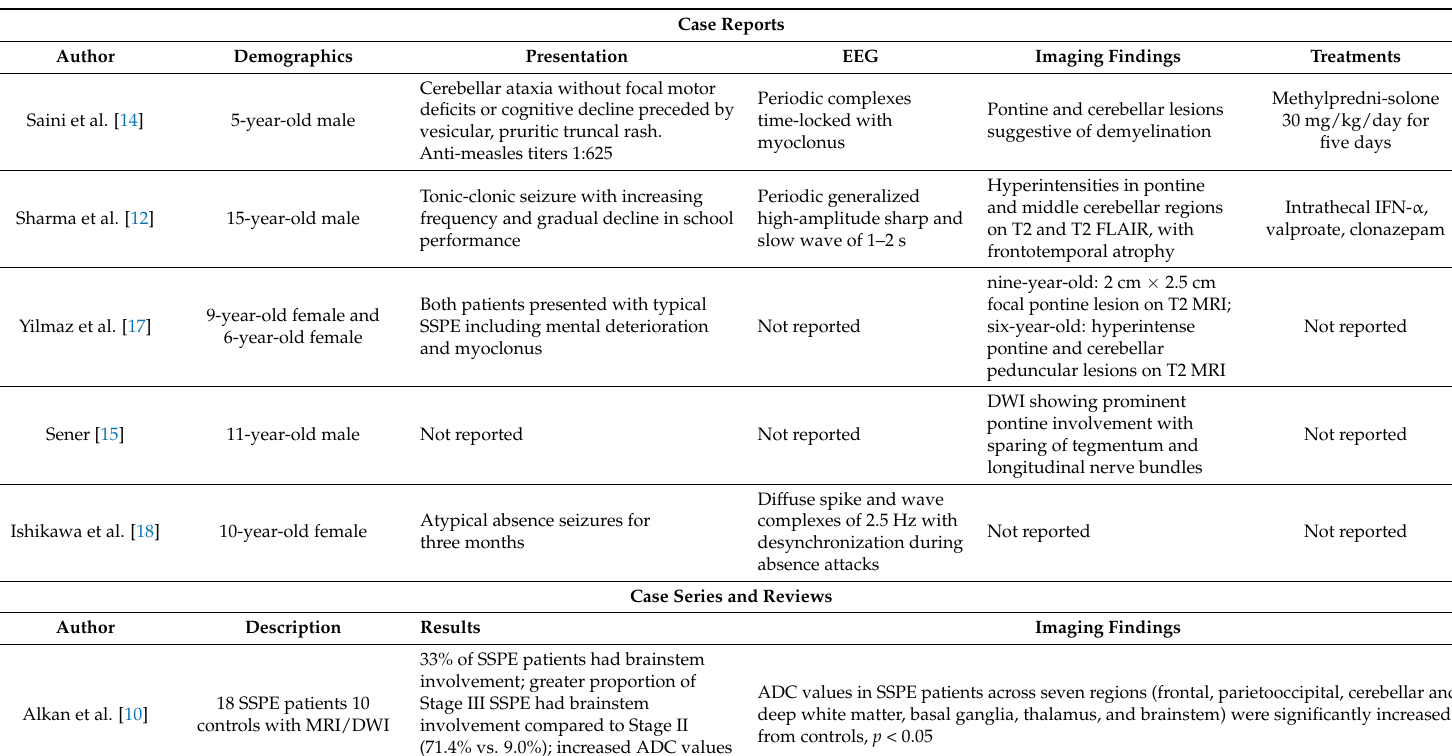
Table 1. Summary of included